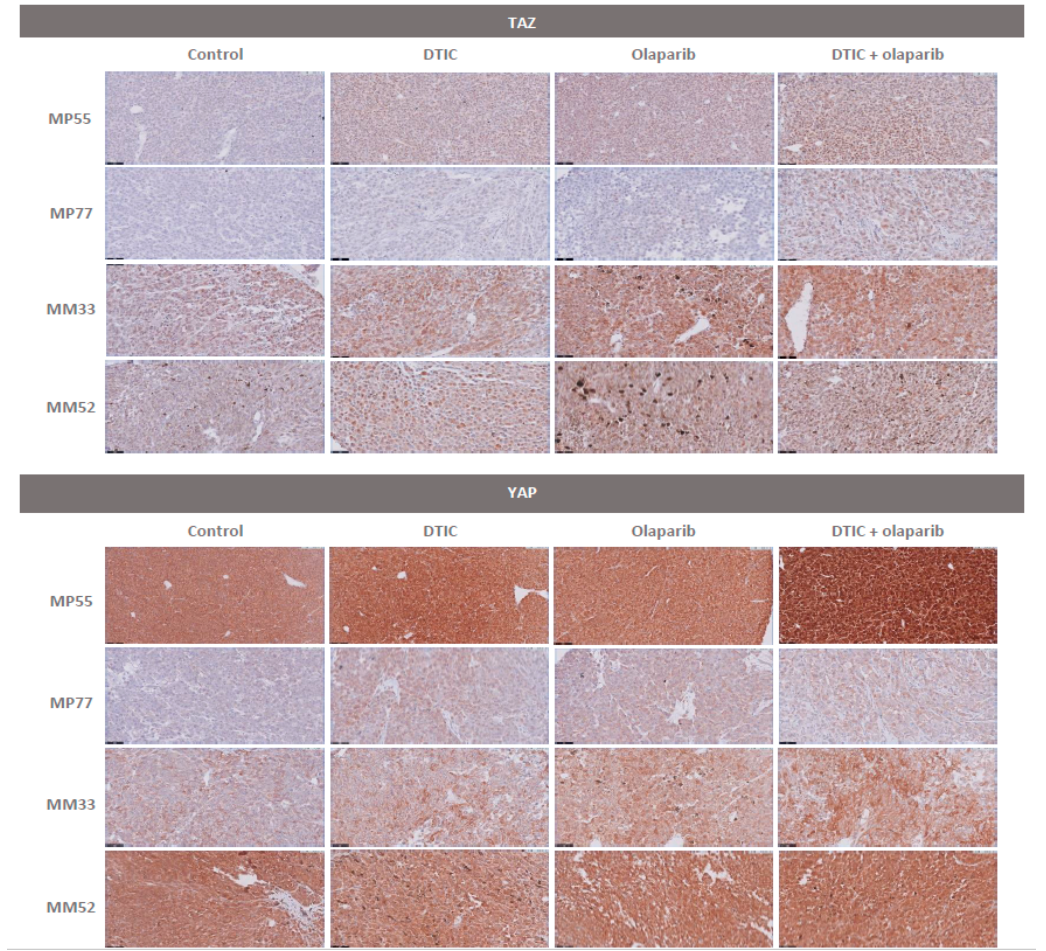
Figure 6. TAZ and YAP protein staining in the four treated PDXs by IHC.